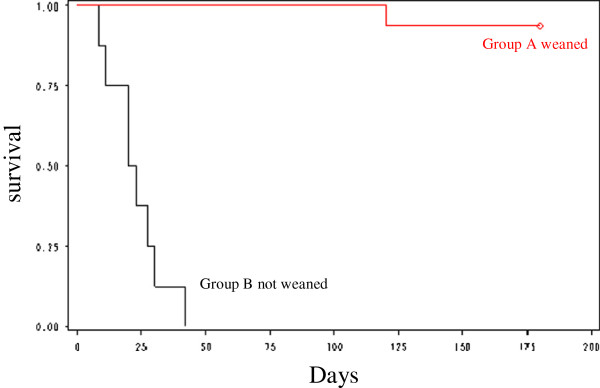
Kaplan-Meier Survival curve of the weaned and not weaned groups.